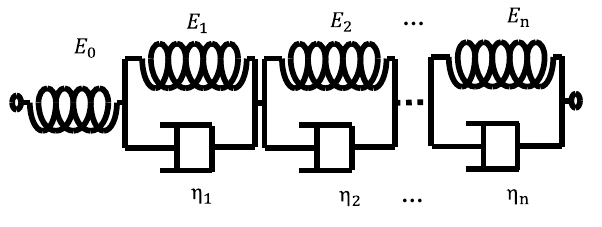
Figure 2. Kelvin–Voigt model.